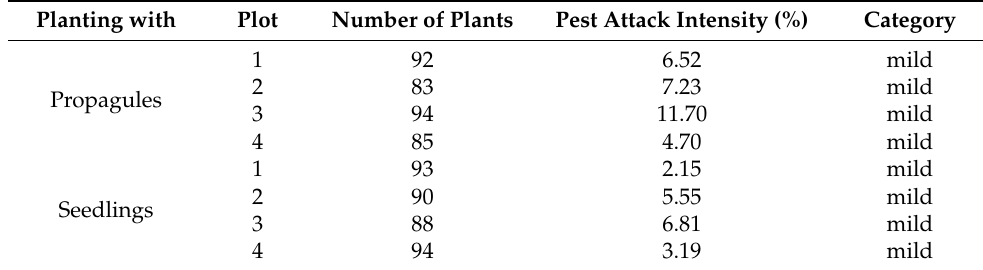
Table 12. Intensity of pest attacks on mangrove stands. Planting with Plot Number of Plants Pest Attack Intensity